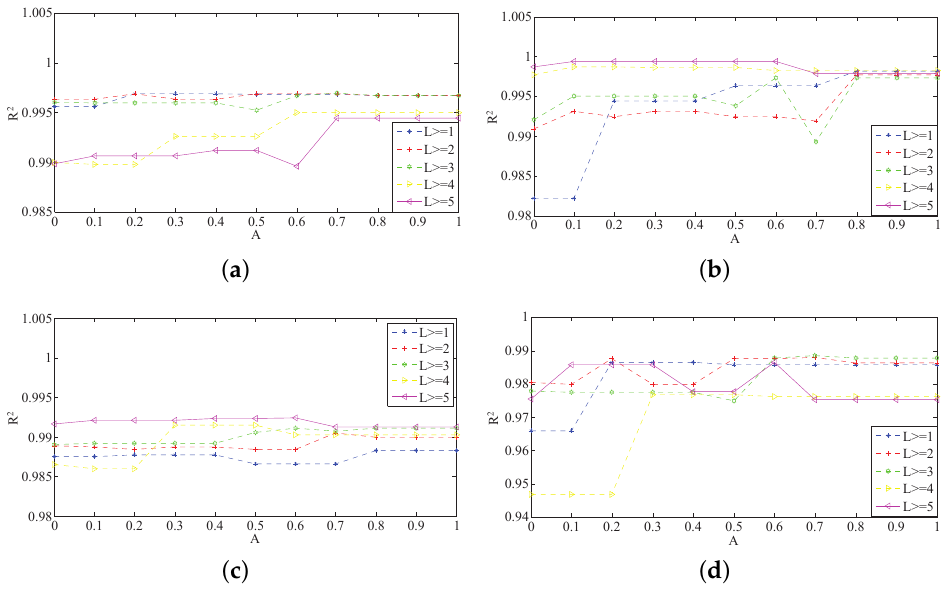
Figure 7. The parameter R 2 change with three weight parameters in 4 conditions: ( a ) the UF Velocity condition, ( b ) the KVS Velocity condition, ( c ) the UF Angle condition, ( d ) the KVS Angle condition.